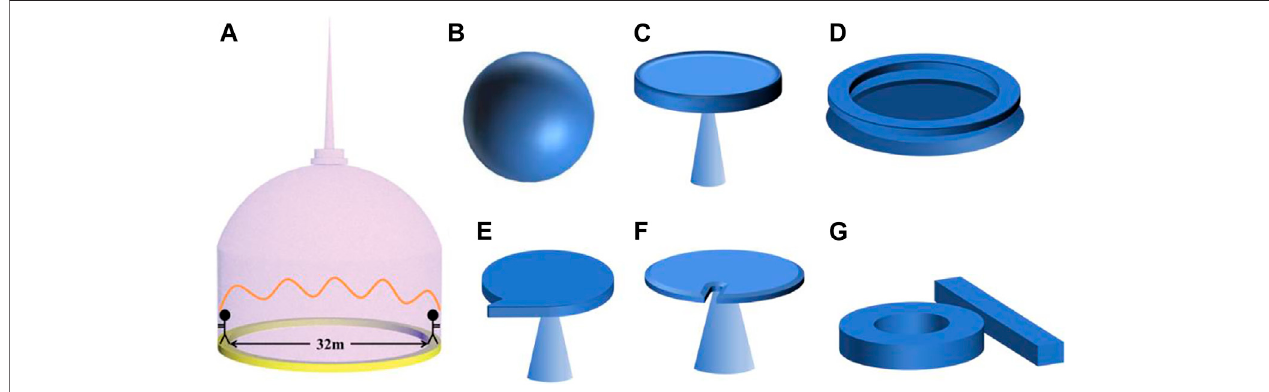
FIGURE 1 | Schematic of various WGM resonators with different structures: (A) dome of St Paul ’ s Cathedral in London (Yang et al., 2015), reprinted with permission © WILEY-VCH Verlag GmbH & Co. KGaA, Weinheim (Yang et al., 2015); (B) microsphere; (C) microdisk; (D) microring; (E) microdisk with chamfering; (F) microdisk with slit; (G) hybrid